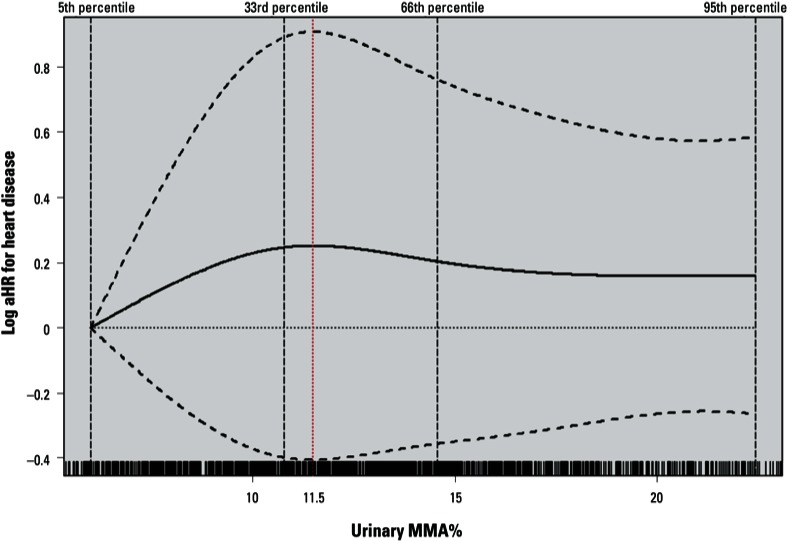
Log aHRs for incident heart disease according to urinary MMA% modeled as a natural cubic spline with internal knots placed at the 33rd and 66th percentiles and boundary knots at the 5th and 95th percentiles adjusted for sex, baseline age (years), BMI, smoking status (never and ever), educational attainment, hypertension, and diabetes status. The ticks at the bottom represent urinary MMA% values and the dashed black vertical lines represent the location of knots used for fitting the cubic spline. The dashed curved lines indicate the 95% CIs of the log aHRs.